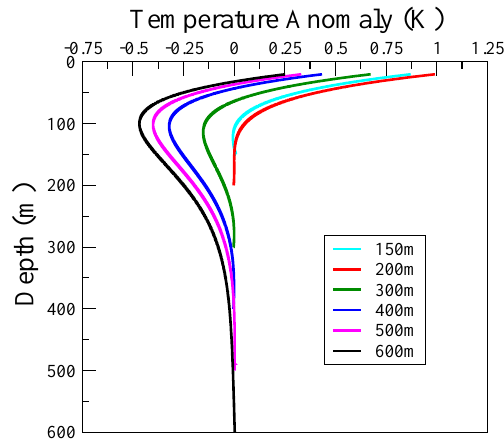
Fig. 2. Subsurface temperature anomalies estimated from the simu- lated temperature profile of Fig. 1c truncated at the depths indicated. The plotted temperature anomalies were derived by subtracting the equilibrium surface temperature and geothermal gradient, both of which were estimated by a least-squares linear regression on the bottom 100m of each truncated profile.